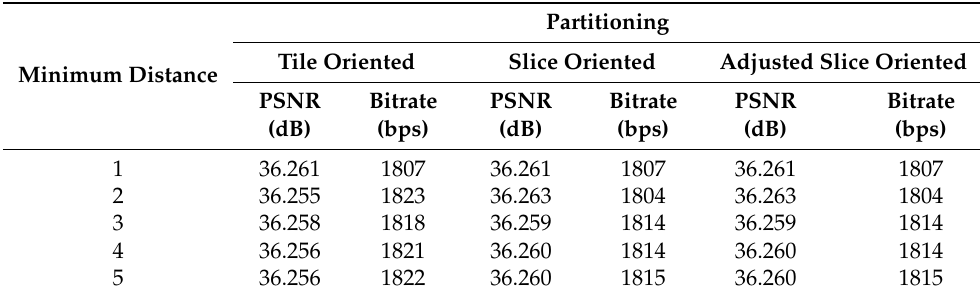
Table 4. PSNR (dB) and Bitrate (bps) for different values of minimum distance.